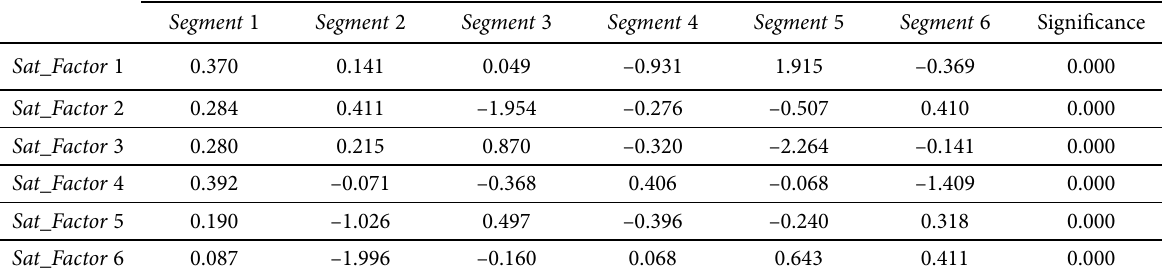
Table 10. Analysis of satisfaction factors among the